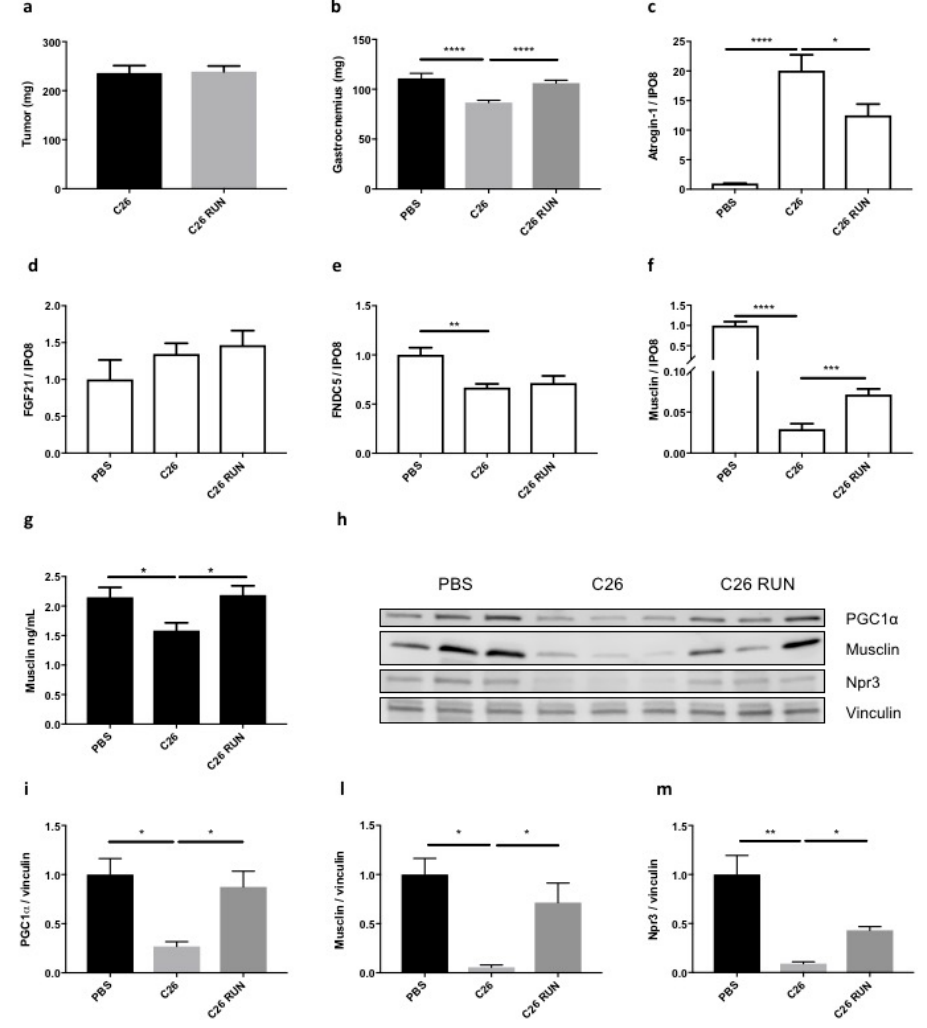
Figure 6. A five-day running schedule fully protects gastrocnemius from wasting in C26-bearing mice, reversing musclin reduction in muscle and plasma. C26 tumor size is not a ff ected by five-day running in mice ( a ), n = 10. The gastrocnemius weight is fully preserved in C26-bearing mice in the running schedule ( b ). One-way ANOVA followed by Tukey’s test, **** p ≤ 0.0001, n = 4–9. C26-induced atrogin-1 expression in gastrocnemius is restrained in the running-trained mice ( c ). While running has no e ff ect on the expression of FGF21 ( d ) or FNDC5 ( e ), the expression of musclin in gastrocnemius ( f ) and the plasma concentration of musclin ( g ) are respectively partially and fully recovered in five day-trained mice. IPO8 was used as housekeeping gene. One-way ANOVA followed by Tukey’s test, * p ≤ 0.05, ** p ≤ 0.01, *** p ≤ 0.001, **** p ≤ 0.0001 n = 8–10. In WB, the protein content of PGC1 α , musclin and its receptor Npr3 in gastrocnemius of C26-bearing mice is restored to levels comparable to tumor-free mice after five-day running ( h ). Densitometric analysis is shown for PGC1 α ( i ), musclin ( l ) and Npr3 ( m ). Vinculin served as loading control. One-way ANOVA followed by Tukey’s test, * p ≤ 0.05, ** p ≤ 0.01, n =